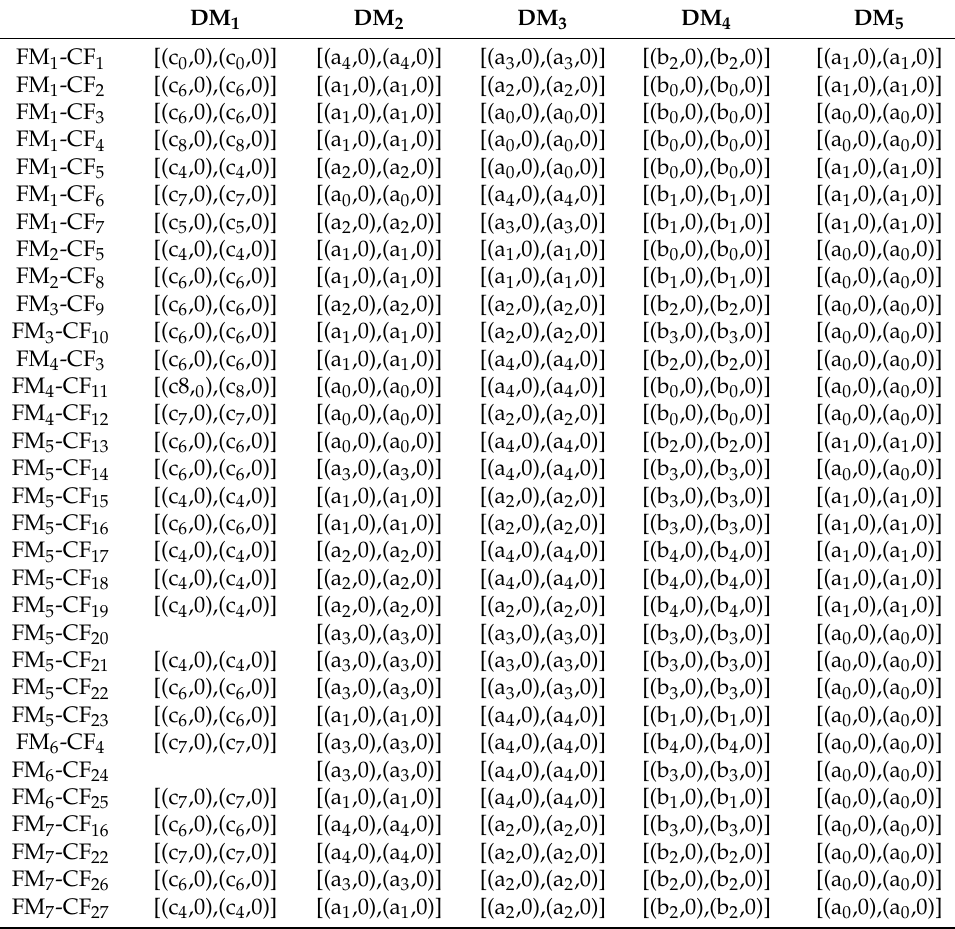
Table 3. Interval 2-tuple linguistic variables for Severity (S).